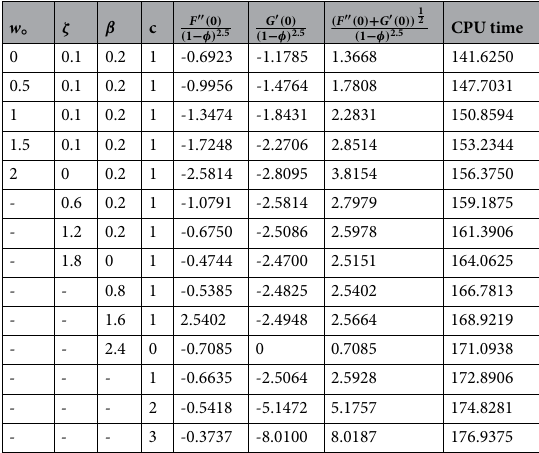
Table 2. Numerical analysis of wall stress τ rw , circumferential wall stress and skin friction coefficient C f for different values of w , ζ , β and c with volume fraction φ ◦